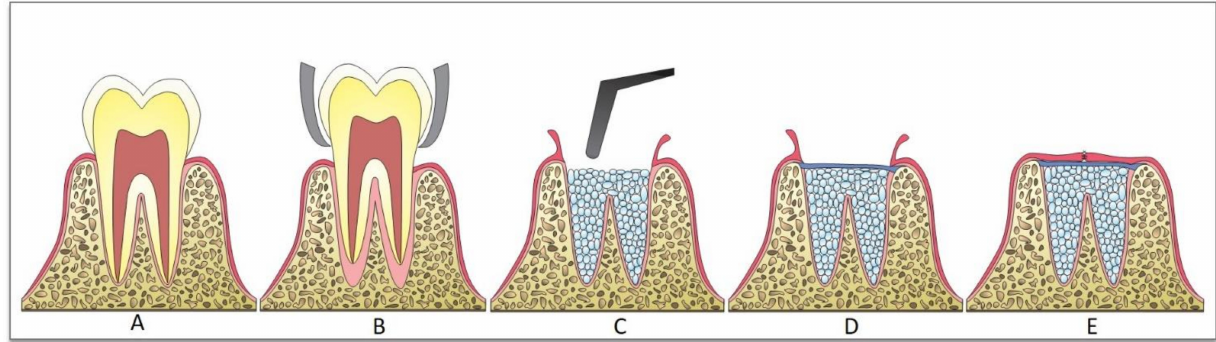
Figure 4. Diagram showing a preventive technique after tooth extraction. ( A ) Dental implantation. ( B ) Dental extraction. ( C ) Filling the dental socket with biomaterial. ( D ) Closure with a membrane. ( E ) Suturing the grafted